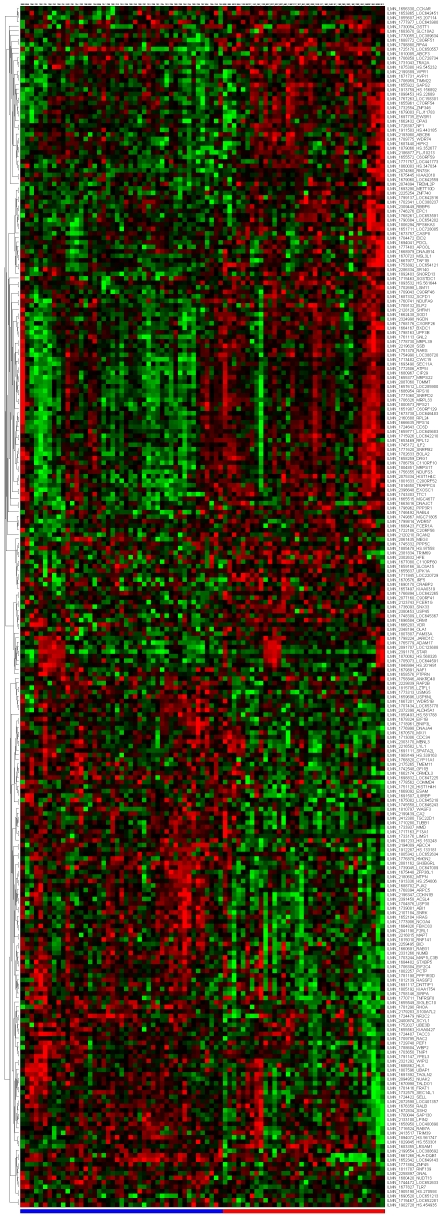
mRNA expression heatmap for the C/RR signature.Control samples (blue), RRMS (red).